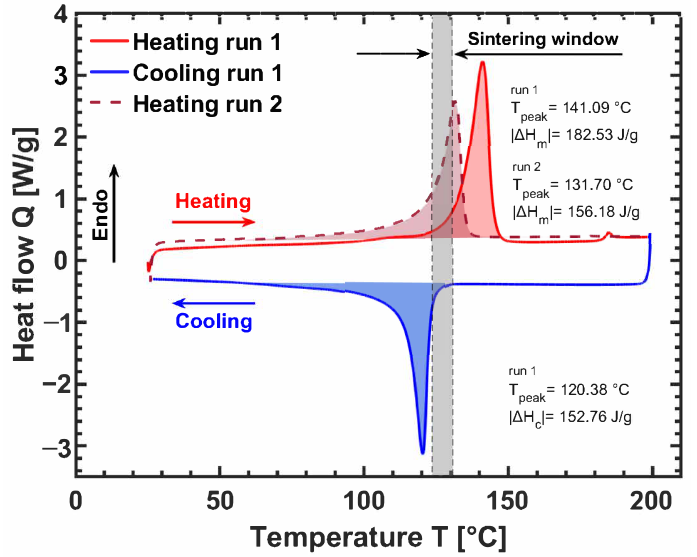
Figure 6. Differential scanning calorimetry thermograph of reactor powder UHMWPE (GUR4120, molecular weight of 4.5 × 10 6 g mol − 1 ) at a heating and cooling rate of 10 ◦ C min − 1 . The red solid and red dashed lines correspond to the melting of the as-polymerized and melt-crystallized powder, respectively. The sintering window is approximately 7 ◦